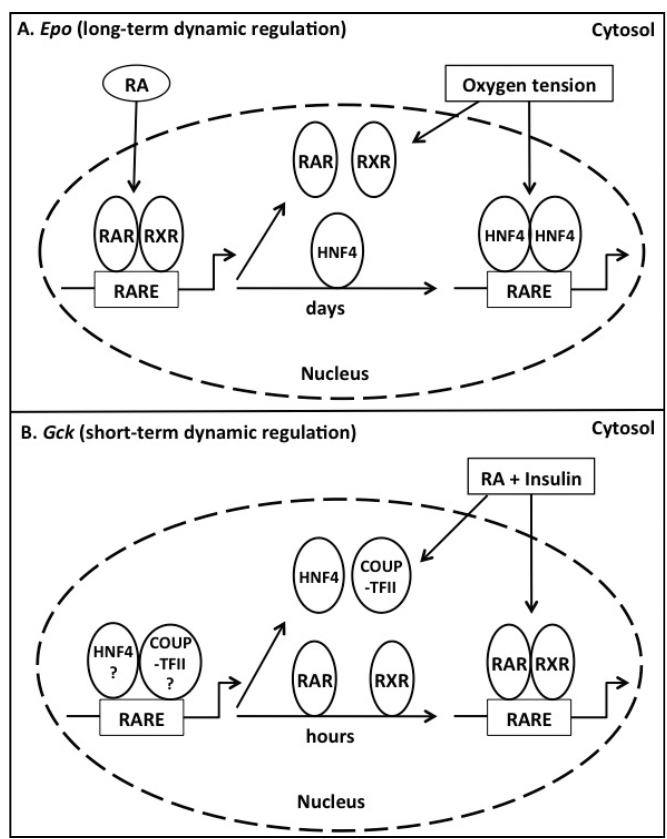
Figure 2. Proposed models of short-term and long-term dynamic regulations of RA-responsive genes. ( A ) Long-term dynamic regulation may take days. For the gene encoding erythropoietin ( Epo ), its transcription is regulated during the E9.5–E11.5 phase of fetal liver erythropoiesis by RAR/RXR heterodimer following binding to RARE located in the promoter and activation by RA. During this phase, other NRs including HNF4, may constantly compete with RAR/RXR for binding to the RARE. Starting from E11.5, RARs and RXRs dissociate from RARE and HNF4/HNF4 homodimer predominantly binds to the RARE and controls Epo transcription in response to the environmental stimulus oxygen tension; and ( B ) Short-term dynamic regulation occurs within hours. In the case of hepatic Gck , HNF4/HNF4 and COUP-TFII/COUP-TFII homodimers, or HNF4/COUP-TFII and COUP-TFII/RXR heterodimers (as indicated by “?”) bind to RARE in the promoter and control the basal transcription of hepatic Gck . Environmental change, such as nutrient influxes, may result in alteration of nutritional (e.g., RA) and hormonal (e.g., insulin) statuses within hours. RA and insulin may modulate the binding of different NRs to the RARE and lead to the replacement of bound dimers with RAR/RXR heterodimer, which in turn, may promote the transcription of hepatic Gck